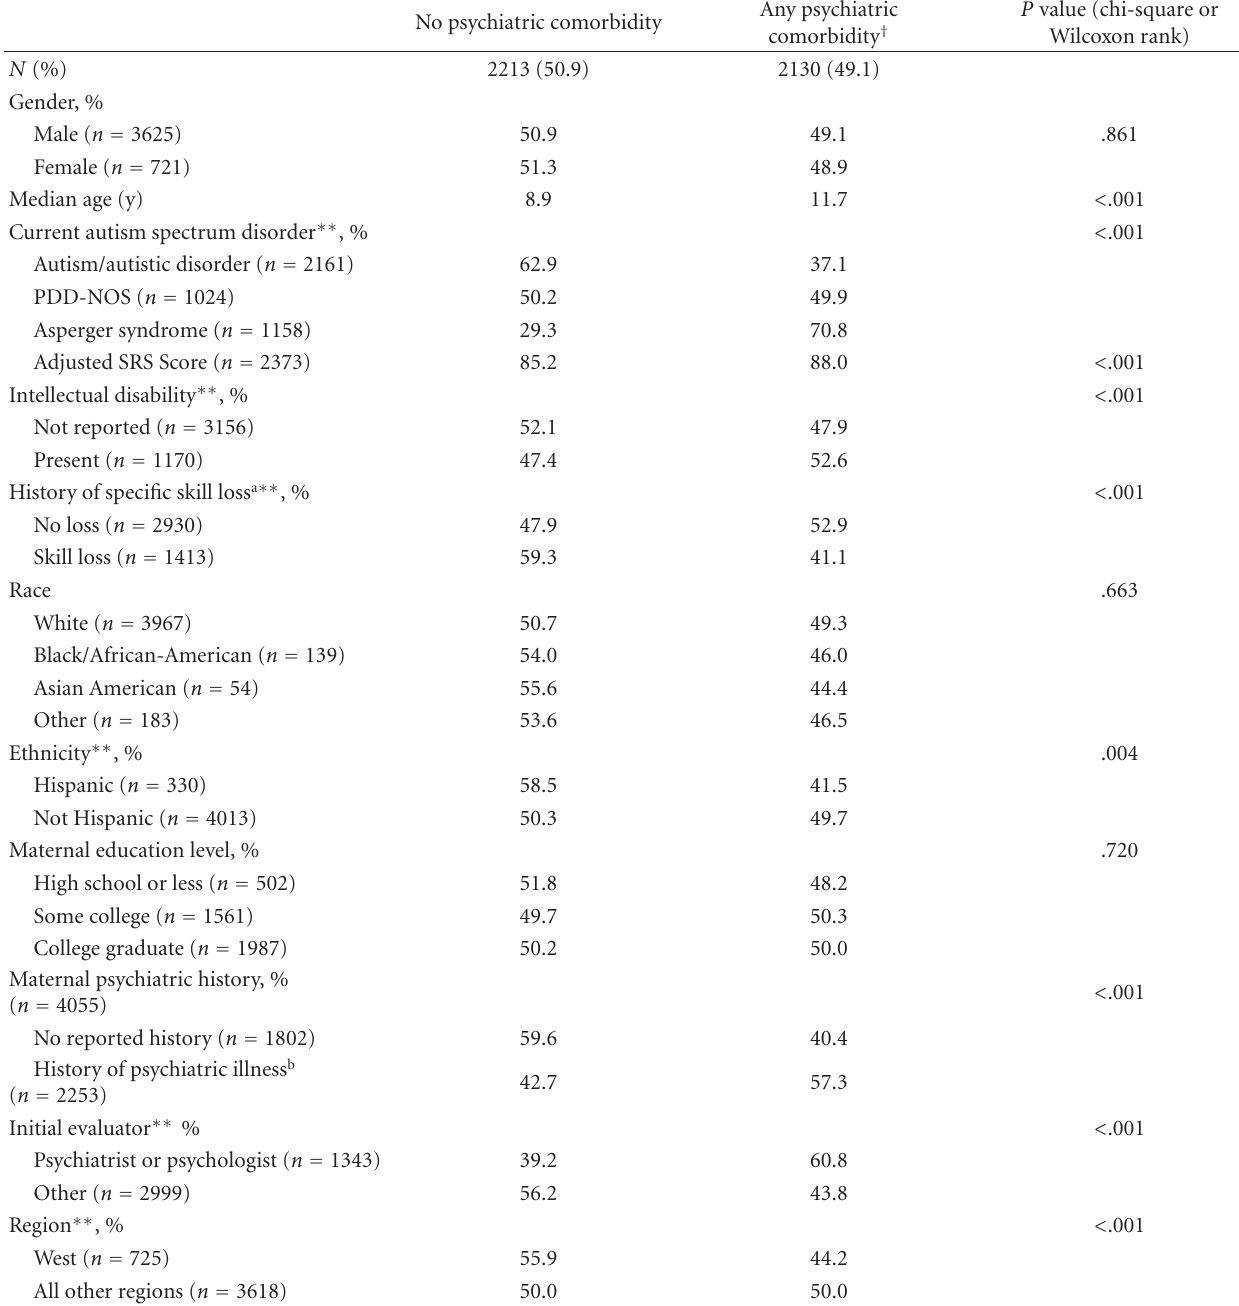
Table 1: Characteristics ∗ of children with ASD, aged 5–18 y by parent-reported lifetime history of psychiatric comorbidity ( n = 4343). No psychiatric